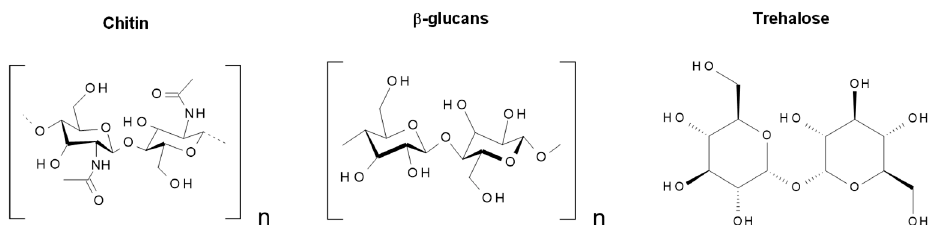
Figure 14. Chemical structure of some of the main components of Lentinula edodes extract.